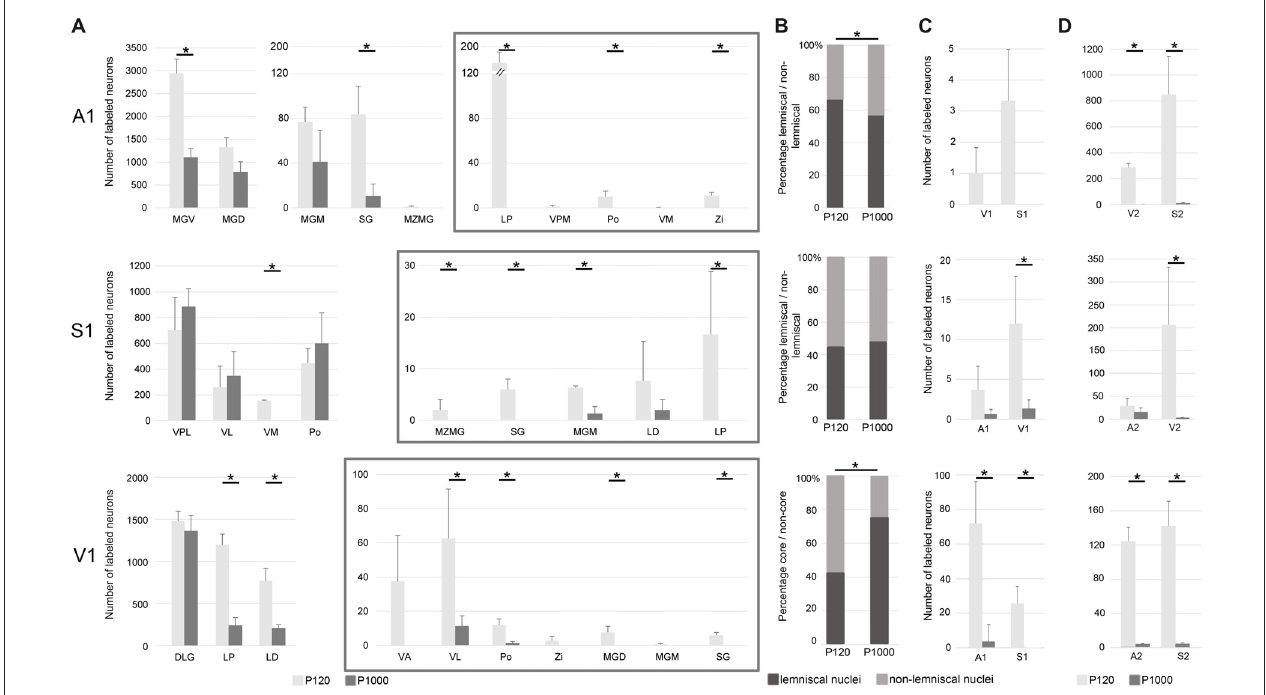
FIGURE 3 | The number of most sensory thalamocortical and intracortical connections of A1, S1, and V1 decreases during aging. (A) Mean number ± 1 SEM of retrogradely labeled neurons in the sensory thalamic nuclei following tracer injections into A1, S1, and V1 listed for P120 and P1000. Non-matched (i.e., crossmodal) thalamocortical connections within each given modality are enframed (gray boxes). (B) Mean percentage of retrogradely labeled neurons in lemniscal (core) and non-lemniscal (non-core) thalamic nuclei on all sensory matched thalamic connections listed for P120 and P1000. (C,D) Mean number ± 1 SEM of retrogradely labeled somata in primary (C) and secondary (D) sensory cortices following tracer injections into A1, S1, and V1 listed for P120 and P1000. Stars indicate significant changes between experimental ages (always ∗ p = 0.033, Kolmogorov-Smirnov (KS) test, n = 3 per age and injection site). Note the different scaling of the x-axes for better visualization of the values. Abbreviations: A1/2, primary/secondary auditory cortex; D/VLG, dorsal/ventral lateral geniculate nucleus; LD, laterodorsal thalamic nucleus; LP, lateral posterior thalamic nucleus; MGD/M/V, dorsal/medial/ventral part of the MGB; MZMG, marginal zone of the MGB; Po, posterior thalamic nucleus; S1/S2, primary/secondary somatosensory cortex; SG, suprageniculate thalamic nucleus; V1/2, primary/secondary visual cortex; VA, ventral anterior thalamic nucleus; VL, ventrolateral thalamic nucleus; VM, ventromedial thalamic nucleus; VPL/M, ventral posterolateral/posteromedial thalamic nucleus; Zi, zona incerta.